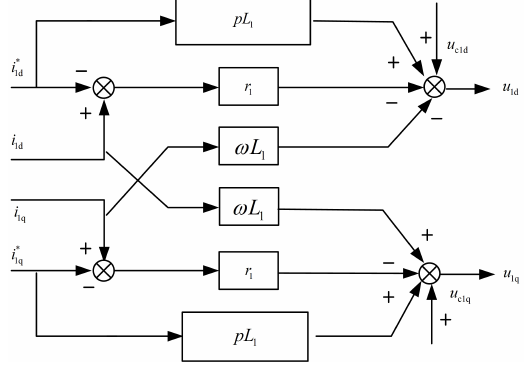
Fig. 4. Block diagram of PBC controller